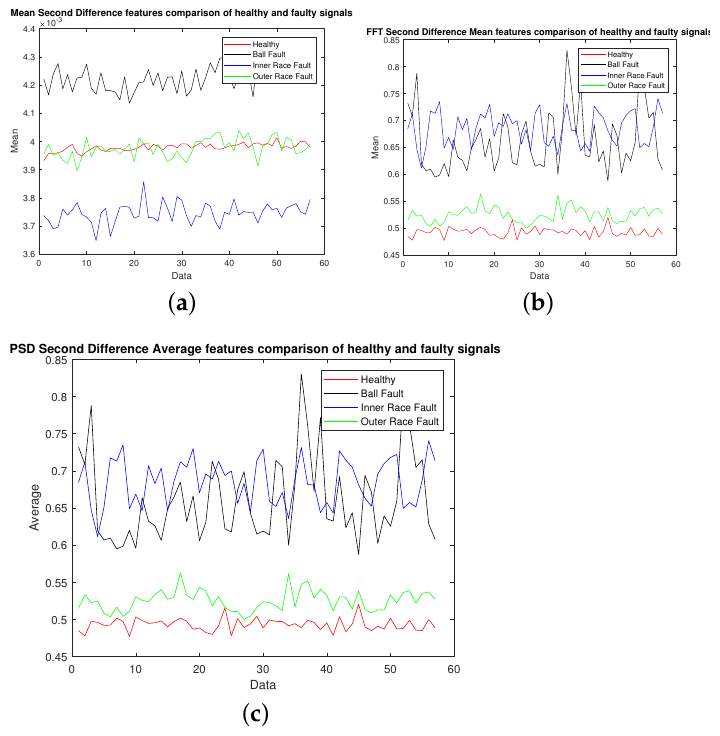
Figure 6. Analysis of mean values of second derivative: ( a ) Average (Time Domain), ( b ) Average FFT, ( c ) Average